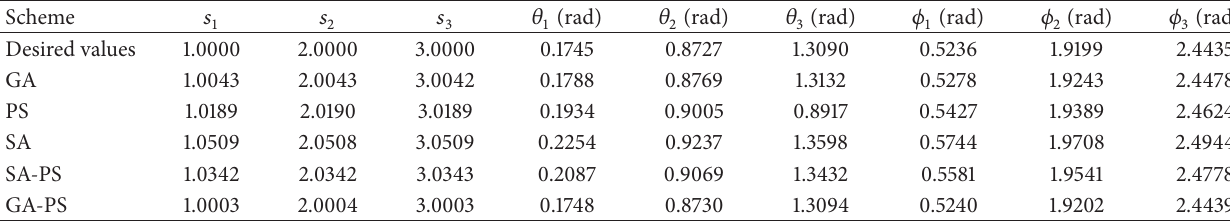
Table 4: Estimation accuracy of 2-L-type array for 3 sources.